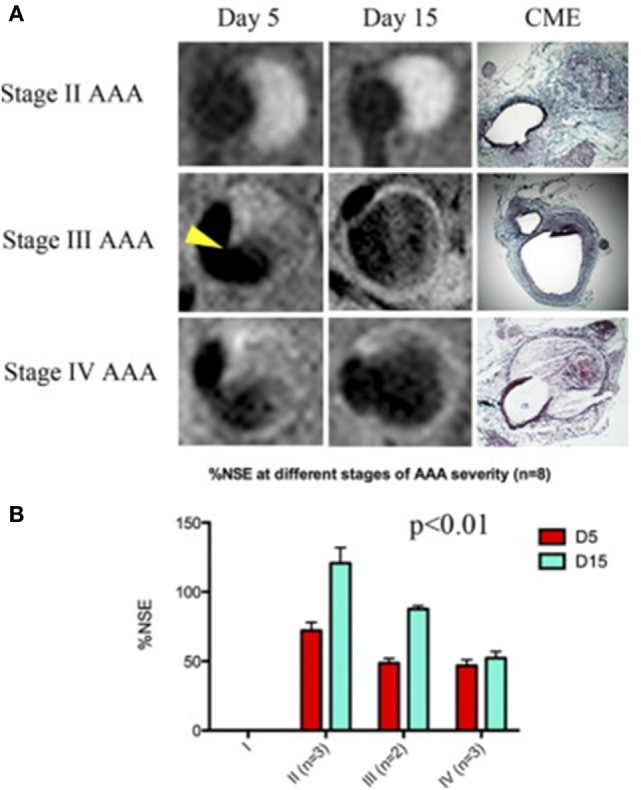
CNA-35-enhanced MR imaging of AAAs of increasing severity at early and late stage of development and complications. (A) Typical image of Stages II–IV AAA obtained after CNA-35 injection. Corresponding histological sections stained with combined Masson elastin are shown in the third column. (B) Quantification of aneurysm severity (increasing from Stage I–IV) and normalized signal enhancement percentage (%NSE) relative to CAN-35 injection. Reprinted from Klink et al. (31), with permission from Elsevier. Abbreviations: %NSE, normalized percentage signal enhancement; AAA, abdominal aortic aneurysm; CNA-35, paramagnetic/fluorescent micellar nanoparticles functionalized with a collagen-binding protein. AAA severity Stages I–IV are based on the classification by Manning et al. (64).